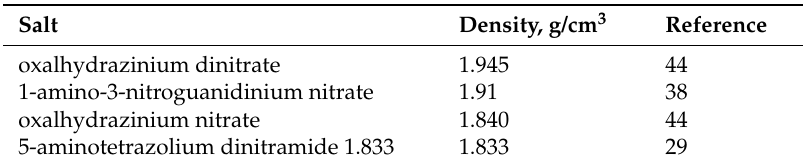
Table 3. Some C,H,N,O nitrogen-rich salts with large cations and small anions that have experimental densities greater than 1.80 g/cm 3 .